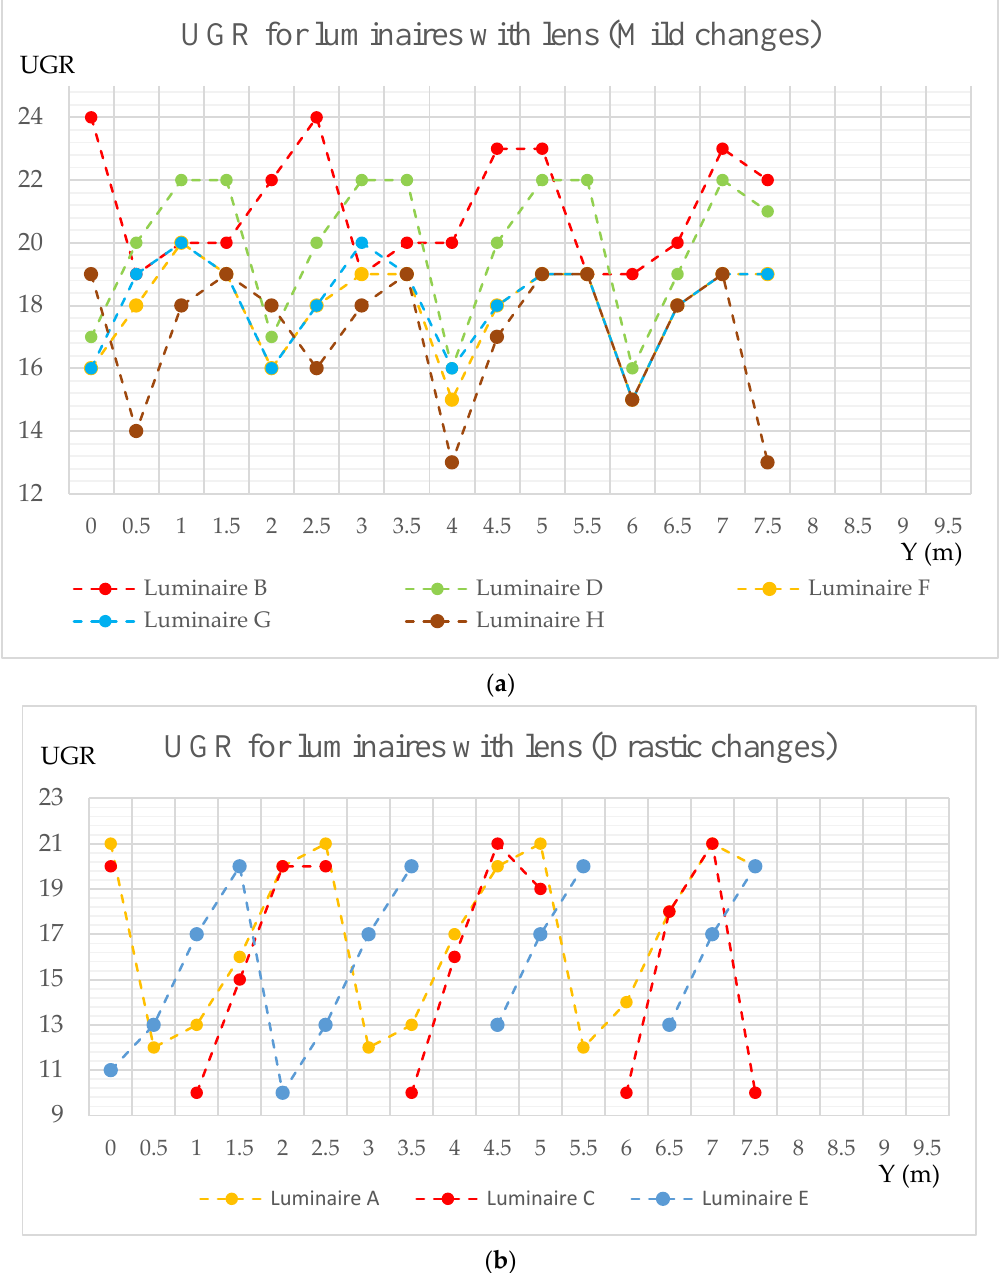
Figure 10. Eight LED luminaires’ UGR curves ( a ) for luminaires with UGR mild changes ( ∆ 𝑚𝑎𝑥−𝑚𝑖𝑛 UGR ≤ 6), and ( b ) for drastic changes of UGR ( ∆ 𝑚𝑎𝑥−𝑚𝑖𝑛 UGR > 6) along the room ’s midline. (For luminaires described in Figure 9a – h along the room ’s midline when the observer’s viewing direction is parallel to the luminaires’ axis).